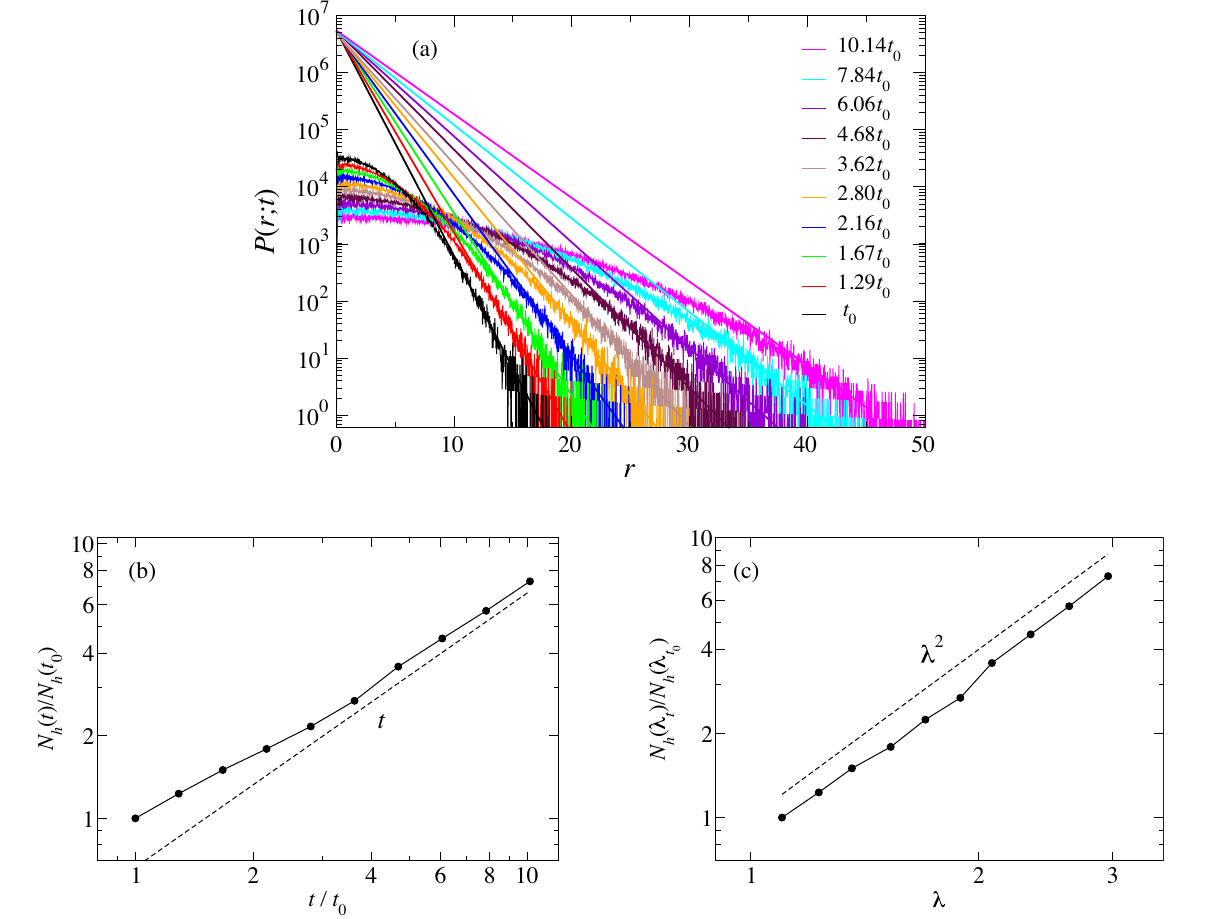
FIG. 11. Testing the scaling behavior for the 2D Kob-Andersen binary mixture at T ¼ 0 . 36 . (a) P ð r ; t Þ at different times t ( > t 0 ), (b) N h ð t Þ normalized by N h ð t 0 Þ showing the expected linear behavior in time, (c) N h ð λ Þ normalized by N h ð λ t